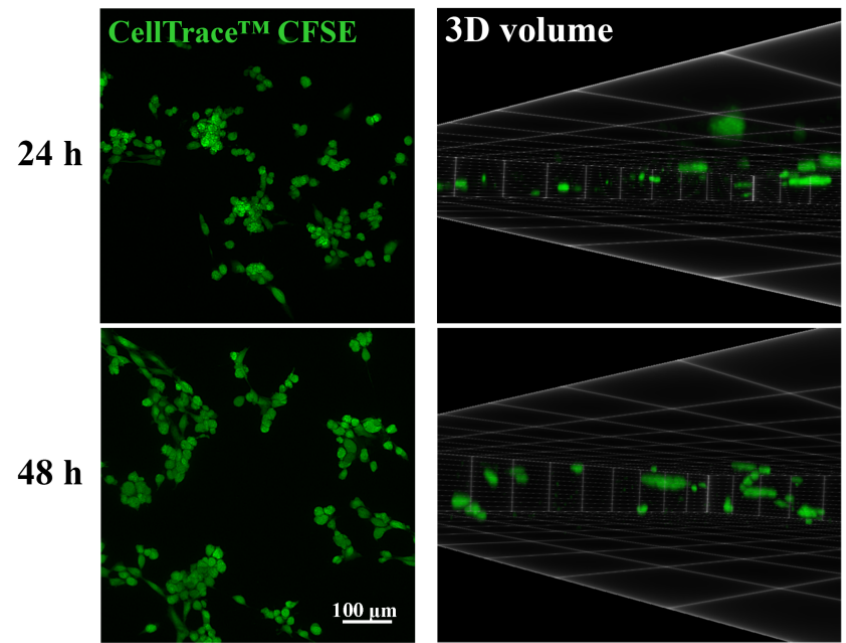
Figure 1. Morphology and localization of SW480 cells in the bacterial nanocellulose scaffold. Repre- sentative images ( left ) and 3D volume ( right ) of cells in the scaffold 24 h or 48 h after seeding. The thickness of the z-stacks used to create 3D volume images was 270 µ m (24 h) and 285 µ m (48 h). The cells were labeled with Cell Trace™ CFSE.